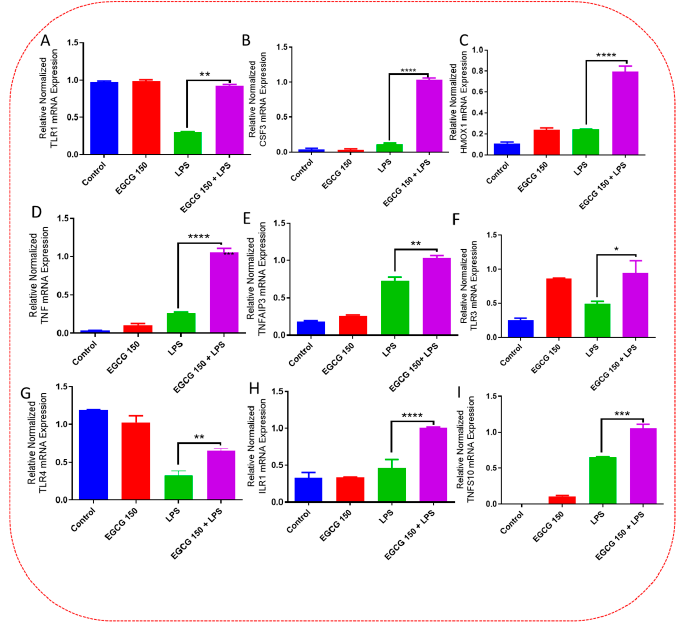
Figure 7. EGCG upregulated neuroprotective-regulating NF- κ B genes. PCR array analysis showed that EGCG 150 µM coupled with LPS (1 µg/mL) elevated mRNA expression of the genes TLR1 ( A ), CSF3 ( B ), HMOX1 ( C ), TNF ( D ), TNFAIP3 ( E ), TLR3 ( F ), TLR4 ( G ), ILR1 ( H ), and TNSF10 ( I ) com- pared to LPS. Values represent the mean ± SD, * p ≤ 0.05, ** p ≤ 0.01, *** p ≤ 0.001 and **** p ≤ 0.0001 vs. LPS.